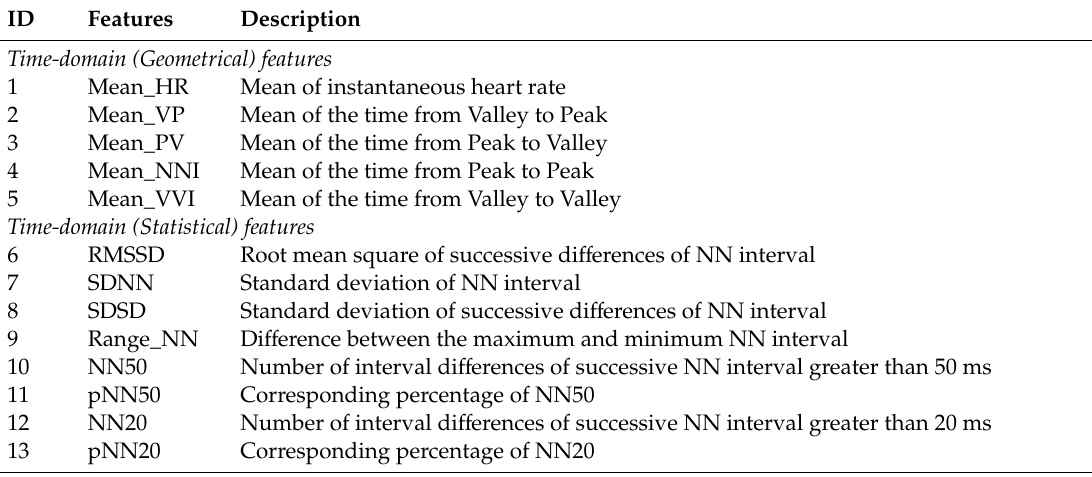
Figure 3. The waveform changes of PPG signal in two emotional states (ILFS was not generated ( a ) and ILFS was generated ( b )). Table 1. Description of photoplethysmography (PPG)